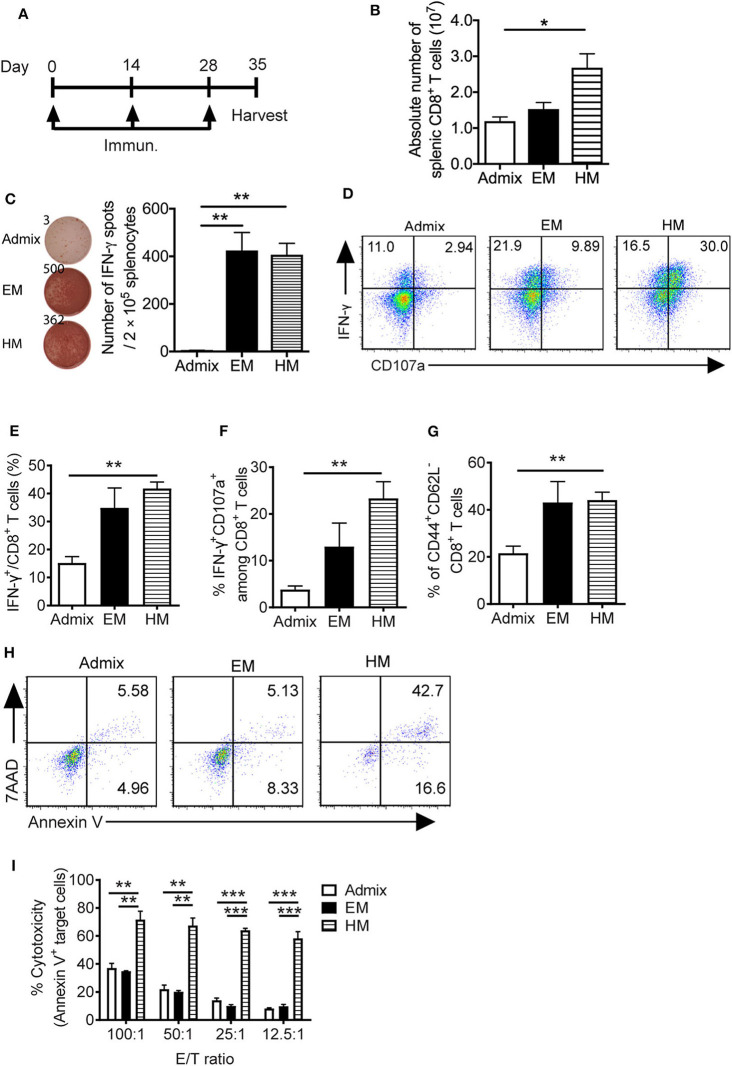
IS-SNAs promote PSA antigen-specific CD8+ T cell responses. (A) Immunization schedule of IS-SNA/PSA65−73. Mice (3 mice per group) were subcutaneously immunized with EM SNA, HM SNA, or admix formulation every 2 weeks for 3 times. Spleens were harvested for analysis 1 week after final immunization. (B) Absolute number of splenic CD8+ T cells from mice immunized 3 times with admix or IS-SNA/PSA65−73. (C) ELISPOT assay was used to measure PSA65−73 specific IFN-γ secreting cells by stimulating splenocytes with PSA65−73 peptide for 48 h. (D–G) Flow cytometry analysis of splenic CD8+ T cells. (D) Representative flow dot plots and bar graph of (E) IFN-γ and (F) IFN-γ and CD107a double positive CD8+ T cells. (G) Percentage of CD44+CD62L− CD8+ T cells. (H,I) Splenic CD8+ T cell cytotoxicity to target cell TRAMP-PSA at different effector/target (E/T) ratio. (H) Representative flow dot plots at 12.5:1 E/T ratio. (I) Summary of CD8+ T cell cytotoxicity reflected by the percentage of apoptotic target cells. All data are presented as mean ± SEM. *p < 0.05, **p < 0.01, and ***p < 0.001, analyzed by two-tailed unpaired Student's t-test.